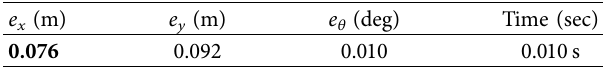
Figure 3: The induced estimation error from the EKF (one landmark and Gaussian noise). Table 1: The mean value of numerical reading of the EKF with (one landmark-Gaussian